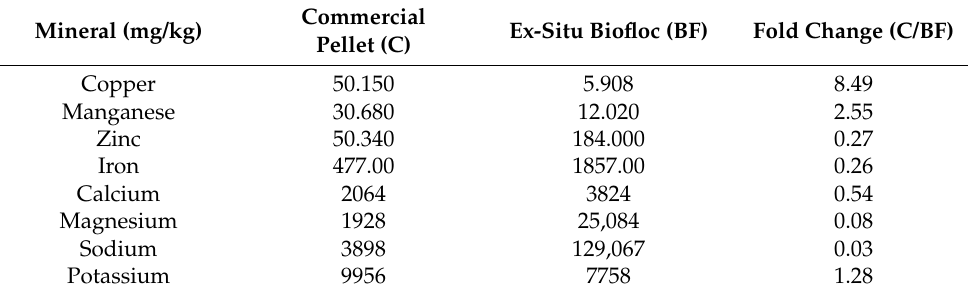
Table 4. Trace mineral analysis between commercial pellet and ex-situ